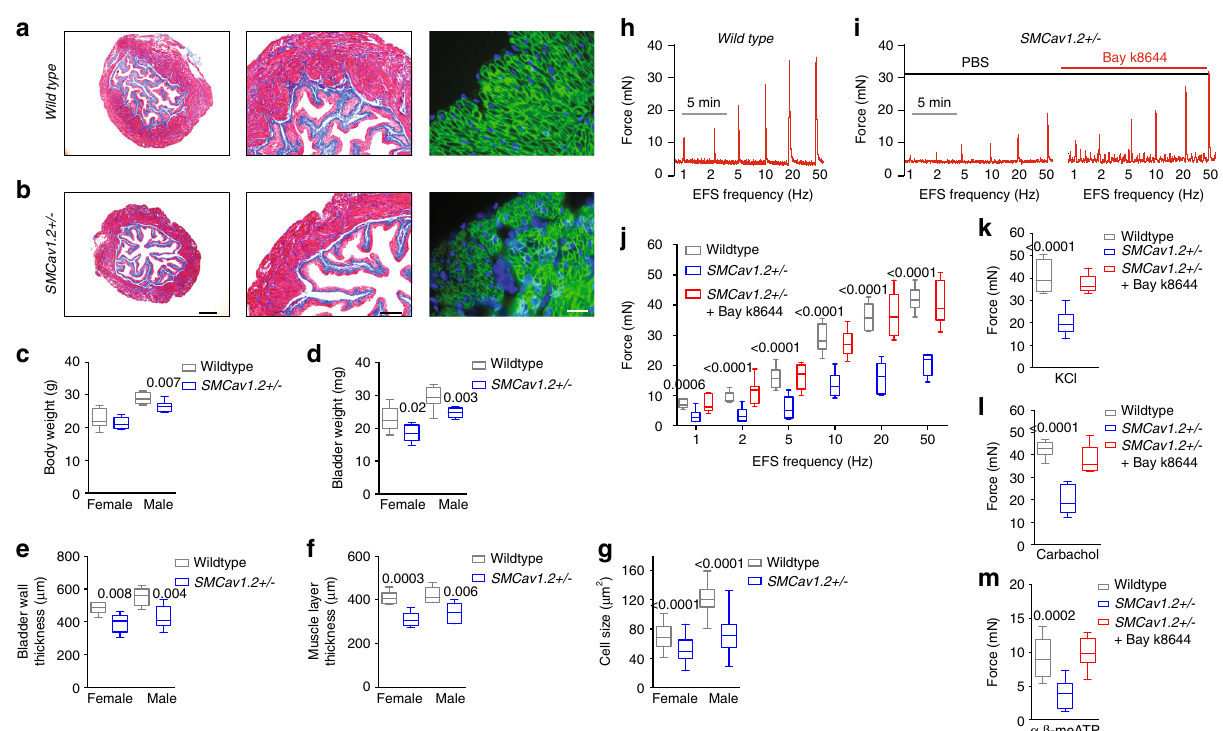
Fig. 8 SMCav1.2 + / − mice exhibit abnormal BSM morphology and contractility. a , b Representative images from three independent experiments: Masson ’ s trichrome stained bladder sections show that SMCav1.2 + /- mouse bladders are smaller with a thinner BSM layer. Scale bars are, from left to right, 400 µ m, 200 µ m, and 20 µ m, respectively. The summarized data are shown in c – f . c , d ( n = 8 mice for both wildtype and SMCav1.2 + / − groups) show that SMCav1.2 + / − mice have lower body weight and bladder weight. e , f ( n = 6 mice for both wildtype and SMCav1.2 + / − groups) show that SMCav1.2 + / − mice have reduced bladder wall and correspondingly lower muscle layer thickness. Individual BSM cells were subjected to immuno fl uorescence staining and imaged with anti β 1 integrin antibody (green) and DAPI for nuclei (blue). BSM cell cross sectional area was quantitated using Fiji software. SMCav1.2 + / − mice BSM cell size was smaller ( g n = 32, 54, 55, and 73 cells for wildtype female, SMCav1.2 + / − female, wildtype male, and SMCav1.2 + / − male mice groups, respectively). h , i Representative BSM contraction force traces in response to EFS show that reduced contraction force measured in SMCav1.2 + / − BSM tissue, was enhanced by Bay k8644. j – m summarized data showing SMCav1.2 + / − mice BSM strips exhibited decreased contraction force in response to EFS stimulation ( j n = 9 BSM strips for both wildtype and SMCav1.2 + / − groups), in response to 50 mM KCl ( k n = 9 BSM strips for both groups), in response to 10 µ M carbachol ( l n = 11 BSM strips for both groups), and in response to 10 µ M α , β -meATP ( m n = 10 BSM strips for both groups). In each condition, contraction was signi fi cantly enhanced by 200 nM Bay k8644. Data are shown as box and whiskers, center line is the median of the data set, box represents 75% of the data, and bars indicates whiskers from minimum to maximum. Data are analysed by two tailed Student ’ s t -test. P < 0.05 is considered to be signi fi cant and P values are given above the bars. Source data are provided as a Source Data fi